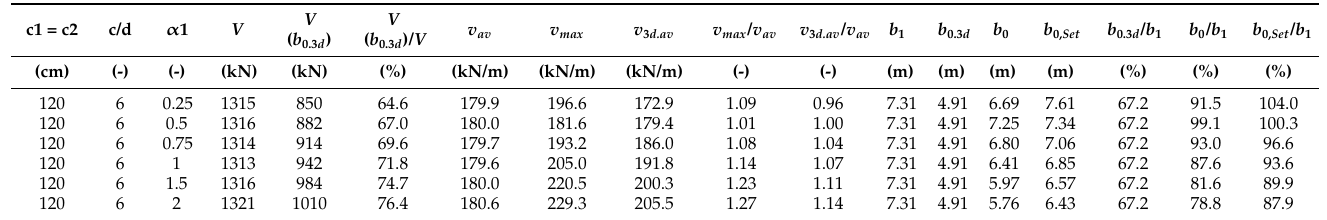
Table A4. Analysis of the shear force distribution in the control perimeter 2 d with 120 cm shear cap size.